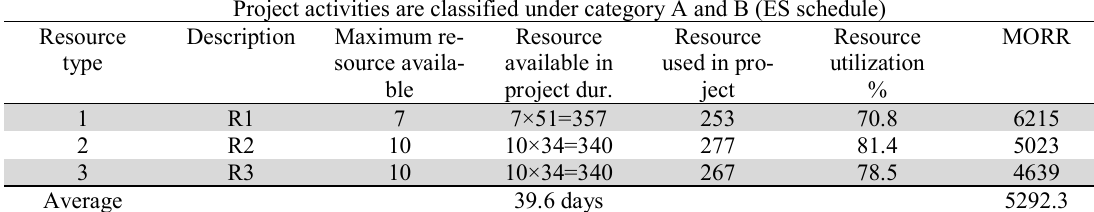
The value of the objective function obtained under ES priority rule for case 2 Project activities are classified under category A and B (ES schedule) Resource